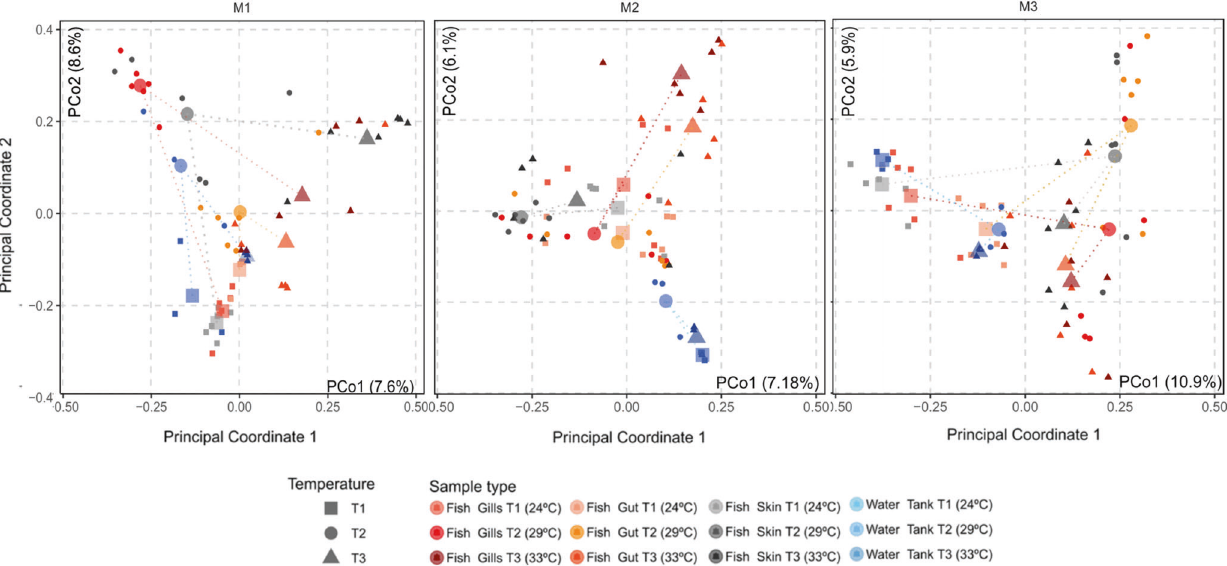
Fig. 2 Beta diversity progression of greater amberjack and water microbiotas throughout marine heatwaves simulation in RAS systems. Beta diversity PCoA, computed upon the Bray – Curtis distance matrix, divided by each sampling timepoint (M1, M2, M3, from left to right). Fish and water samples, from the three water temperatures assessed in the study, are shown in different shapes: squares for 24 °C (T1), circles for 29 °C (T2) and triangles for 33 (T3). Each sample type has been colored differently. For each combination of samples belonging to the same type and temperature, we computed and plotted the centroid of the corresponding cluster. Afterwards, centroids belonging to the same sample type have been joined sequentially depending on the sampled month (T1 – T2 –